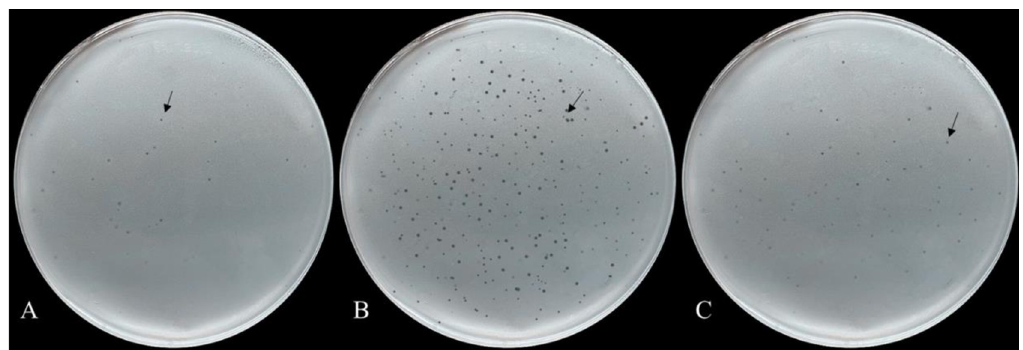
Fig 3. Efficiency of plaque formation. Phage lysate was mixed with Lm3-22, Lm3-22- Δ rliB and Lm3-22- Δ rliB ::B. The resulting plaques were observed on double-layer plates. (A) Phage plaque formed using Lm3-22. (B) Phage plaque formed using Lm3-22- Δ rliB. (C) Phage plaque formed using Lm3-22- Δ rliB ::B.